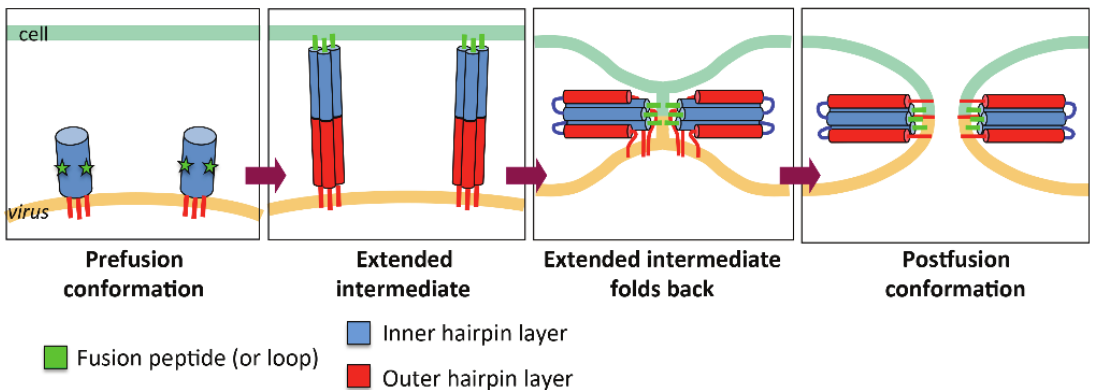
Figure 1. A diagram illustrating viral membrane fusion. Stages in the refolding of a fusogen are indicated. The regions of the fusogen that become the inner and outer layers of the postfusion hairpin are shown in blue and red, respectively. The fusion peptides (or loops) are shown in green.